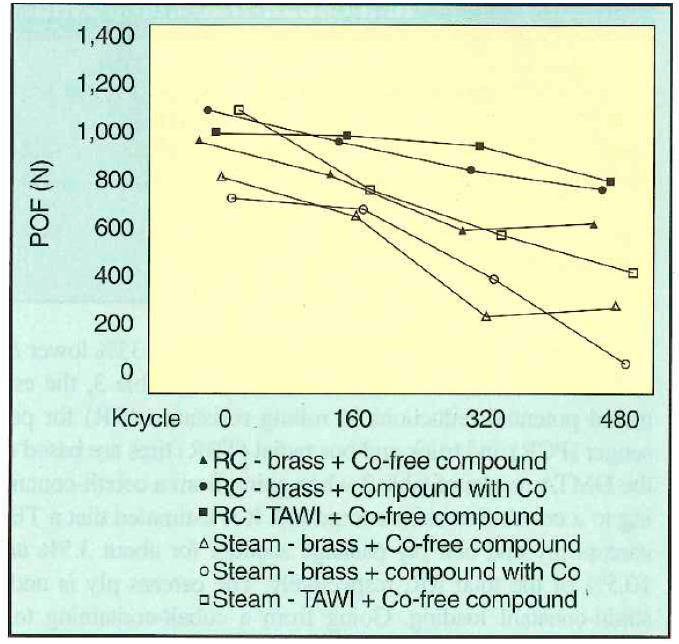
Figure 27. POF (pull-out force) adhesion results of Cu-Zn-Co and Cu-Zn after the RC treatment (25-min cure at 150 °C) and steam aging (24 h at 105 °C). Reprinted with permission from ref. [58].